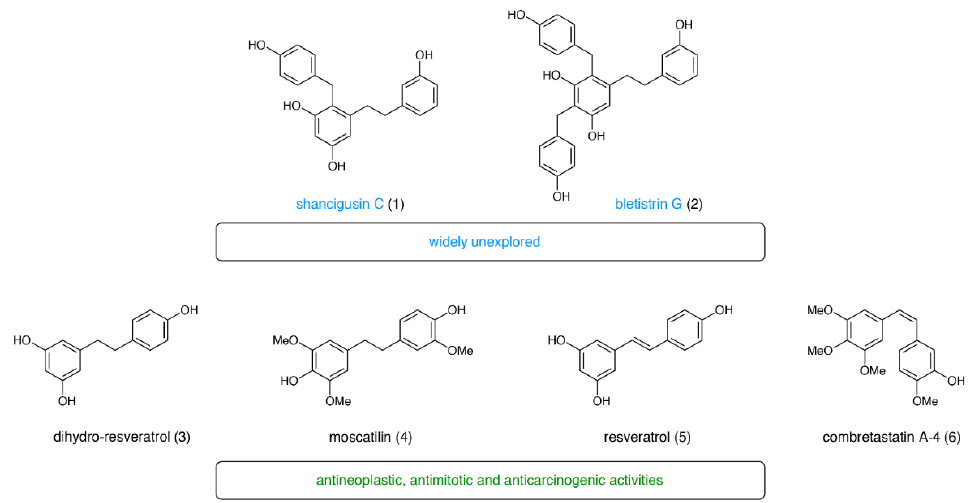
Figure 1. Polyhydroxylated and methoxylated stilbenes and dihydrostilbenes isolated from orchidaceous plants.